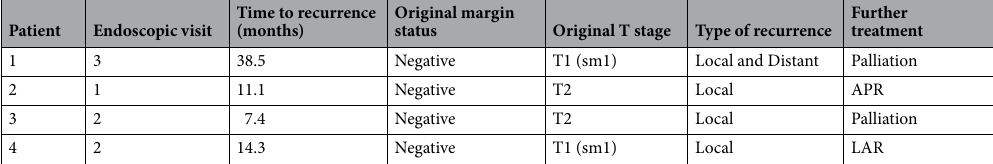
Table 5. Summary of Adenocarcinoma